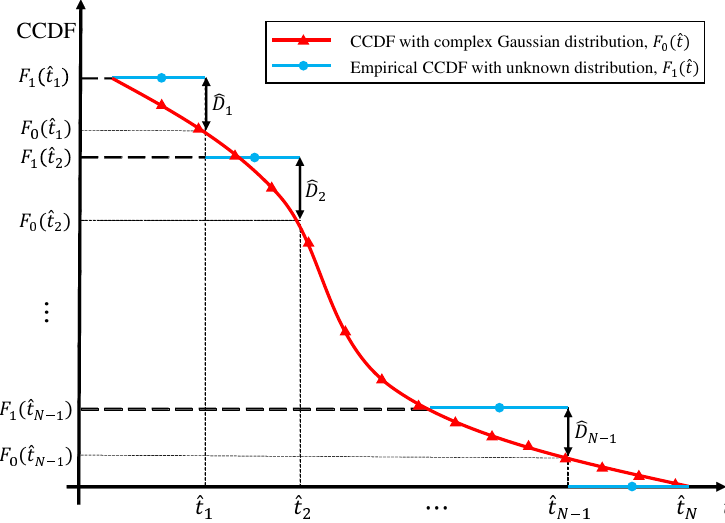
Figure 2. Plotting empirical CCDF with unknown distribution, theoretical CCDFs of complex Gaussian distribution and the differences ˆ D 1 , ˆ D 2 , · · · , ˆ D N − 1 between them on ˆ t 1 , ˆ t 2 , · · · , ˆ t N − 1 for the proposed test. N is the number of the received samples. F 0 ( ˆ t i ) is the theoretical CCDF on ˆ t i under the hypothesis. ˆ D i is the differences between empirical and theoretical CCDFs on